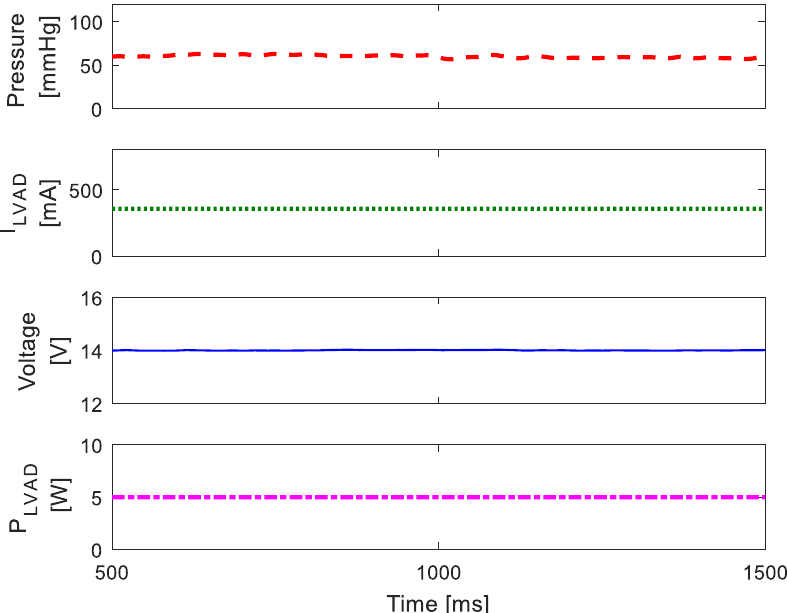
Figure 2. Mock circulatory loop used to characterize LVAD power requirements.